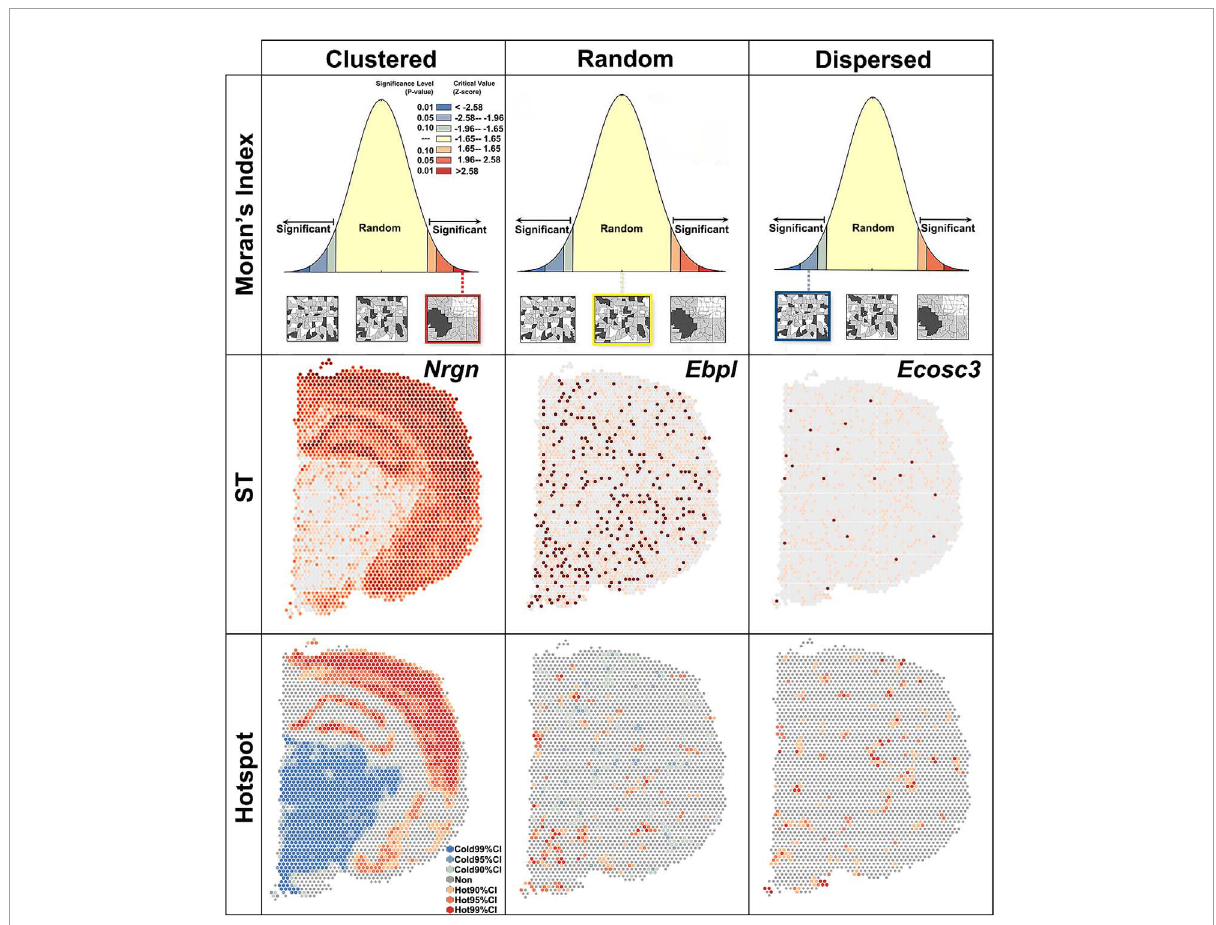
FIGURE2 Global Moran’s index revealing three spatial autocorrelation patterns. Clustered, z > 1.65 and P < 0.1; random, –1.65 < z < 1.65 and P > 0.1; dispersed, z < –1.65 and P < 0.1. ST, spatial transcriptomic; CI, confidence